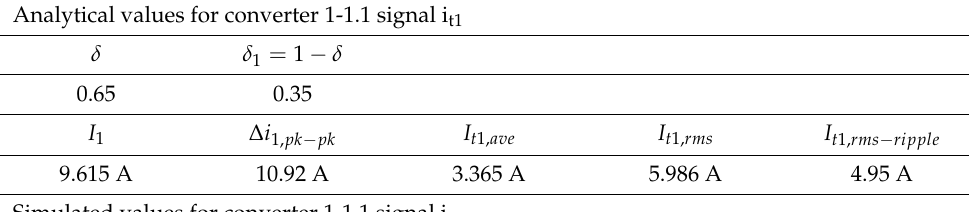
Table 1. Analytical and simulated data for converter 1-1.1 when in CCM.